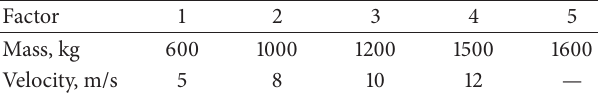
Table 8: Factors and levels of